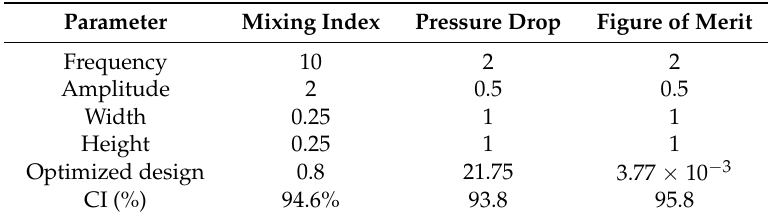
Table 4. Optimum combination of design factors.